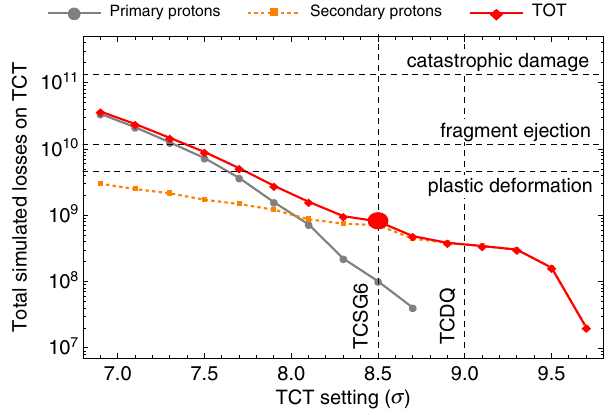
FIG. 14. Simulated losses expected at the TCT compared with the estimates of damage for Case 2. The separated contribution of primary and secondary protons is shown in grey. The losses are estimated assuming a bunch population of 1 . 3 × 10 11 p = b.